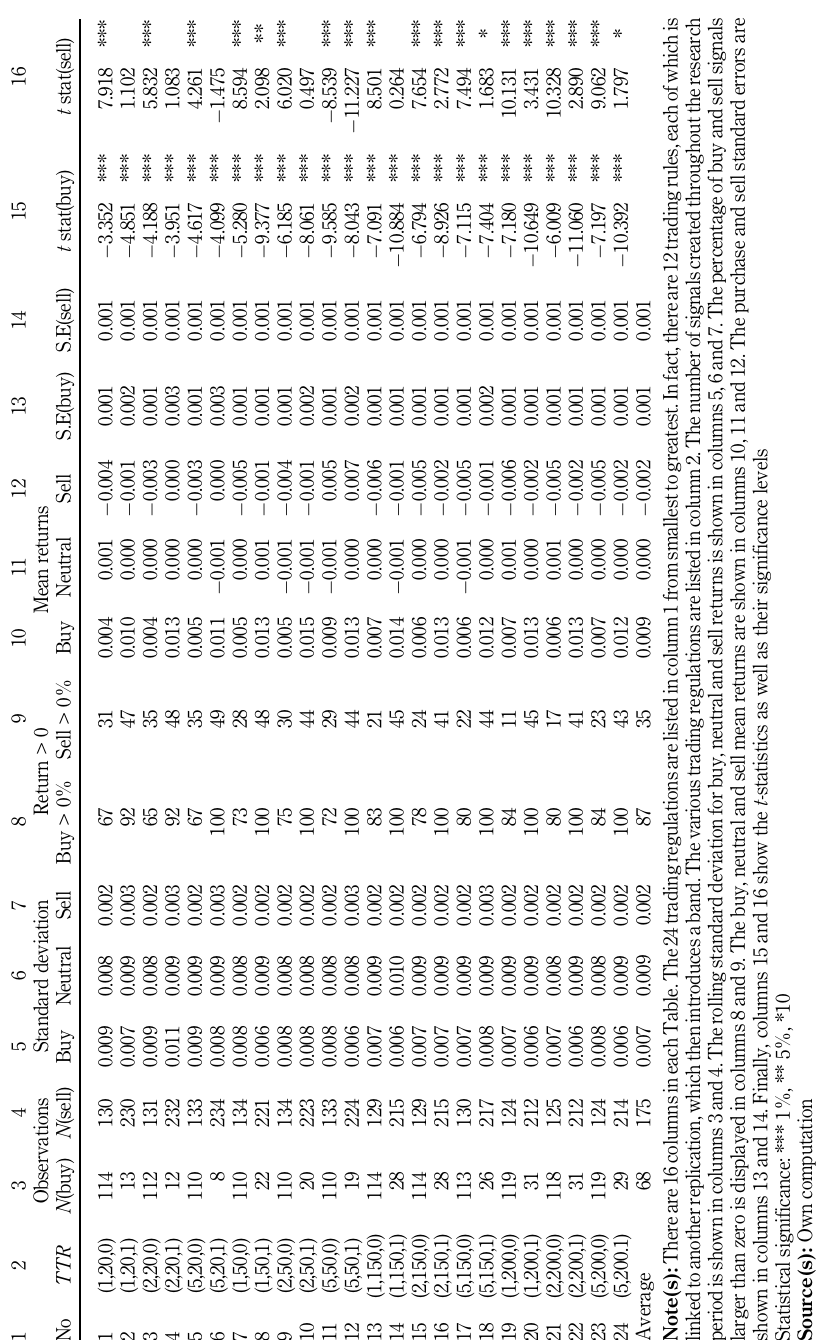
Table 2. BTC/AUD results